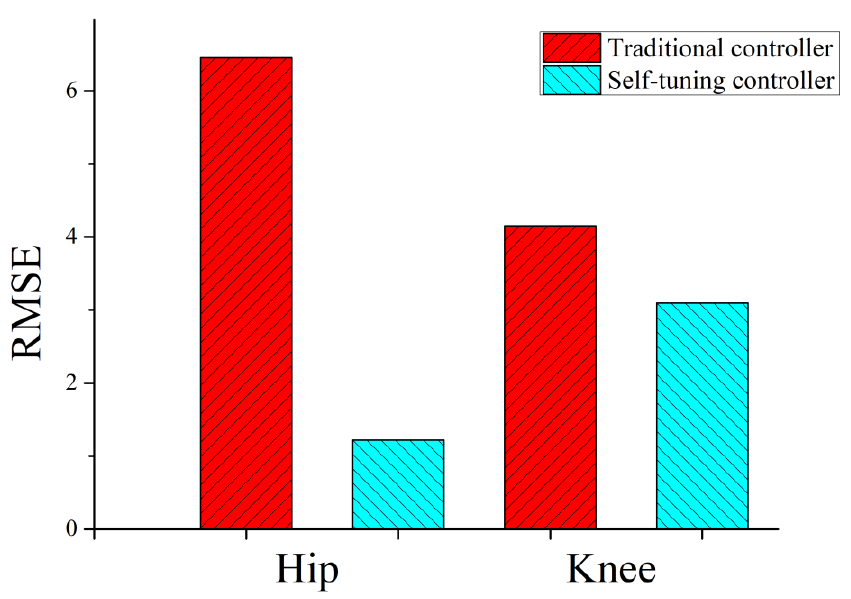
Figure 24. Results of the RMSE of conventional and self-tuning controllers.